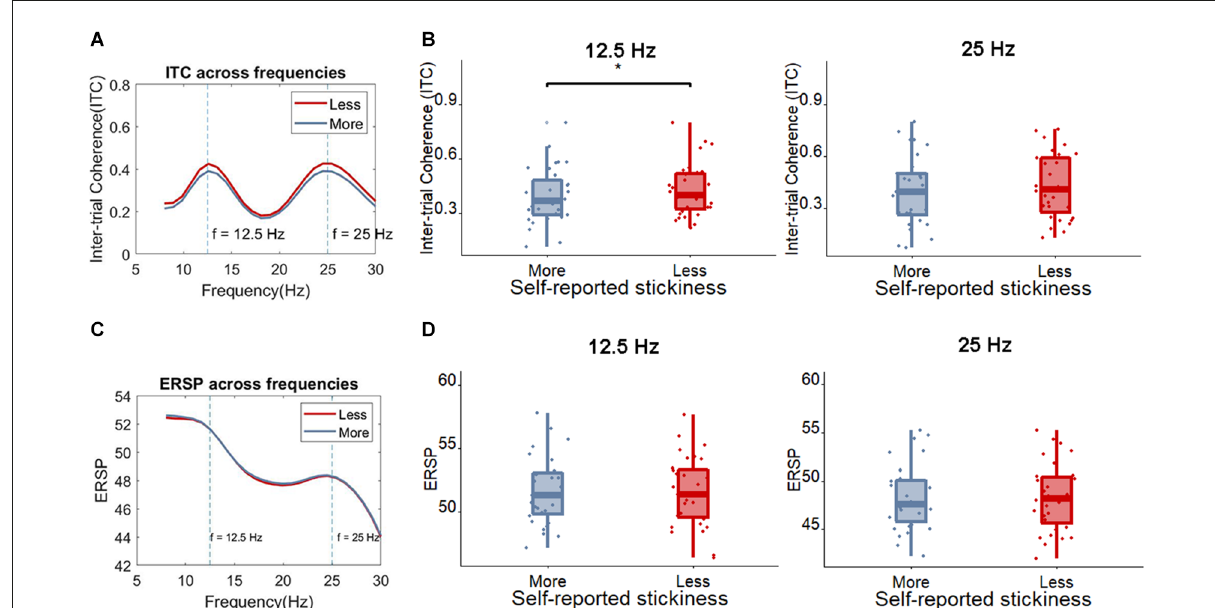
FIGURE5 (A) The average ITC across frequencies for less sticky and more sticky trials. (B) Boxplot of the ITC at the frequency of 12.5 Hz and 25 Hz for less sticky and more sticky trials, each dot represents one participant. (C) The average ERSP ((log)dB) across frequencies comparing less sticky and more sticky trials. (D) Boxplot of the ERSP at the frequency of 12.5 Hz and 25 Hz for less sticky and more sticky trials, each dot represents one participant. Significant differences are indicated with an